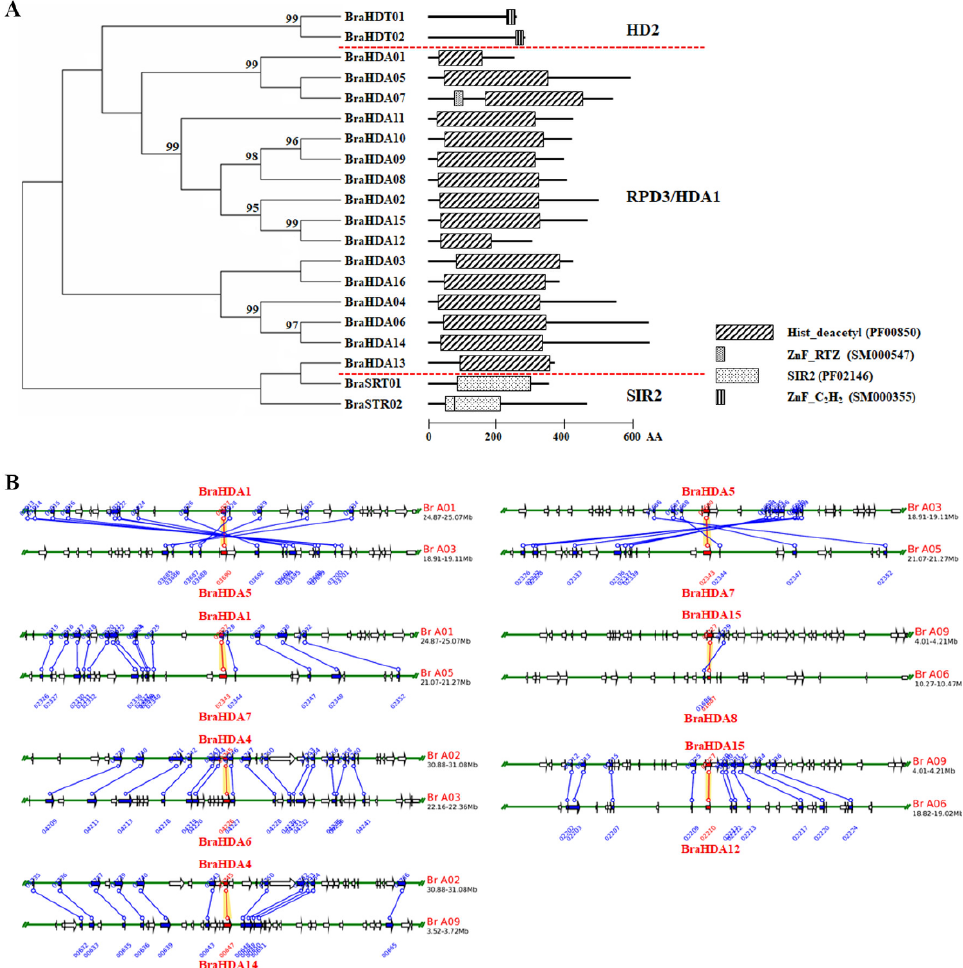
Figure 1. Phylogenetic tree, domain architectures ( A ) and synteny analysis ( B ) of the Brassica rapa HDAC family. Using the neighbor-joining method, phylogenetic tree was generated. The conserved domains in the putative BraHDACs were analyzed with the SMART program. Paralogous gene pairs were analyzed using plant genome duplication database. Table 1. Histone deacetylase gene family in Brassica rapa .